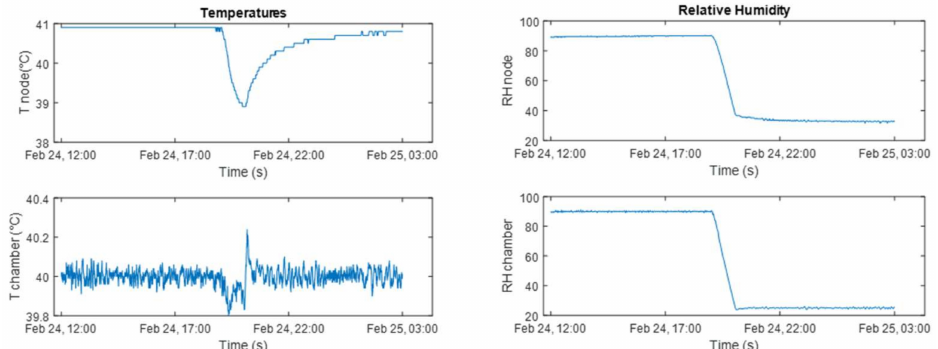
Figure 11. Comparison between the temperature and the relative humidity measured by the climatic chamber embedded sensors (Tchamber, and RH chamber) and by the sensor node (Tnode and RH